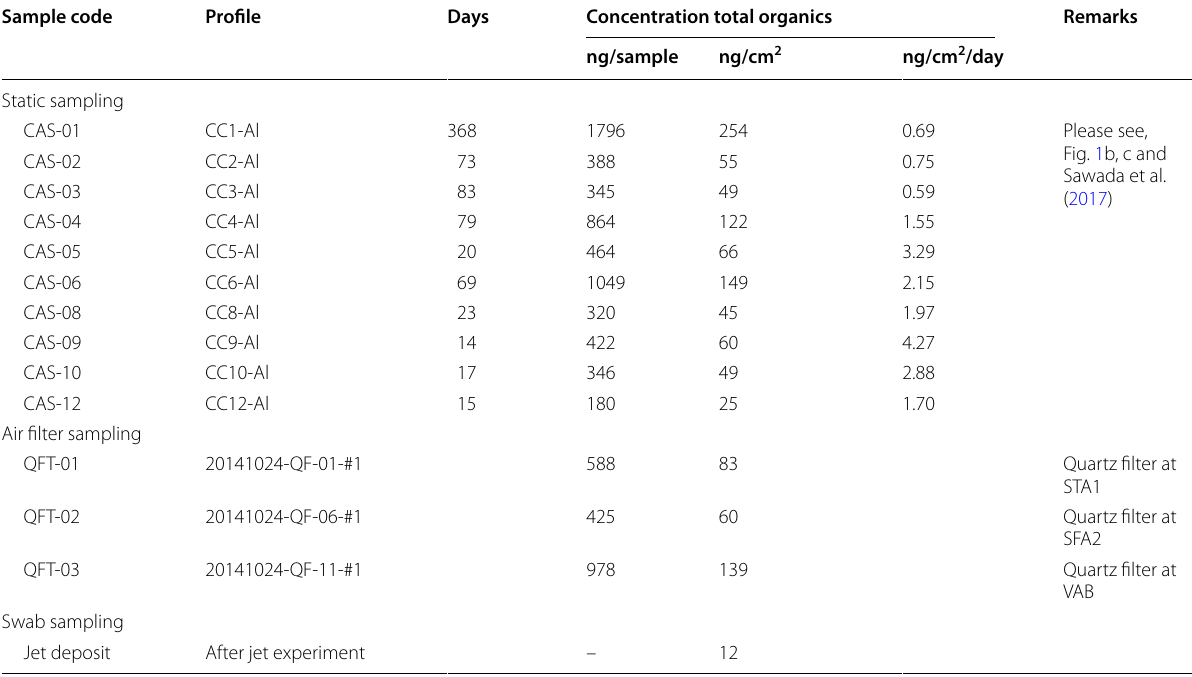
Table 4 Concentration of total organics from static and air-filter sampling during sampler-system development up to the launch of the Hayabusa2 spacecraft